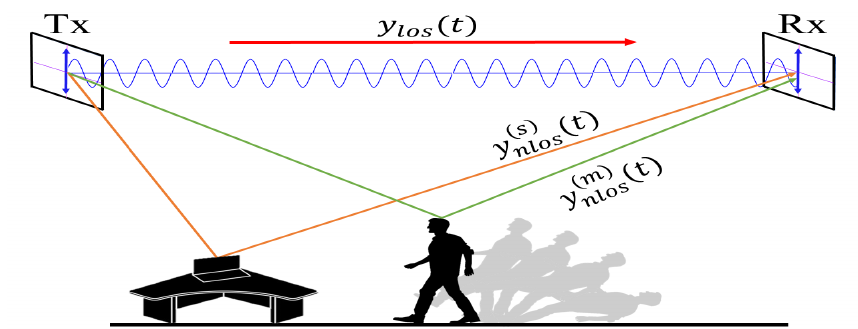
Figure 3. Schematic propagation of an RF signal in a real test